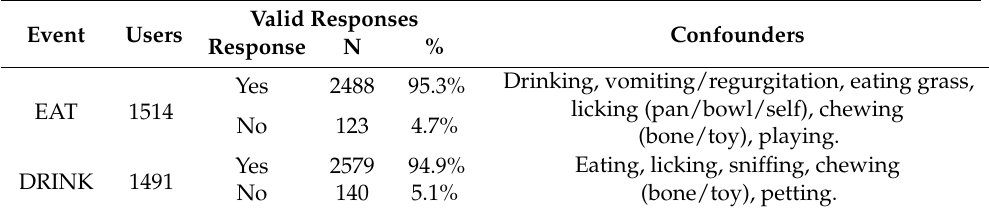
Table 8. Summary of user EAT and DRINK validation responses.